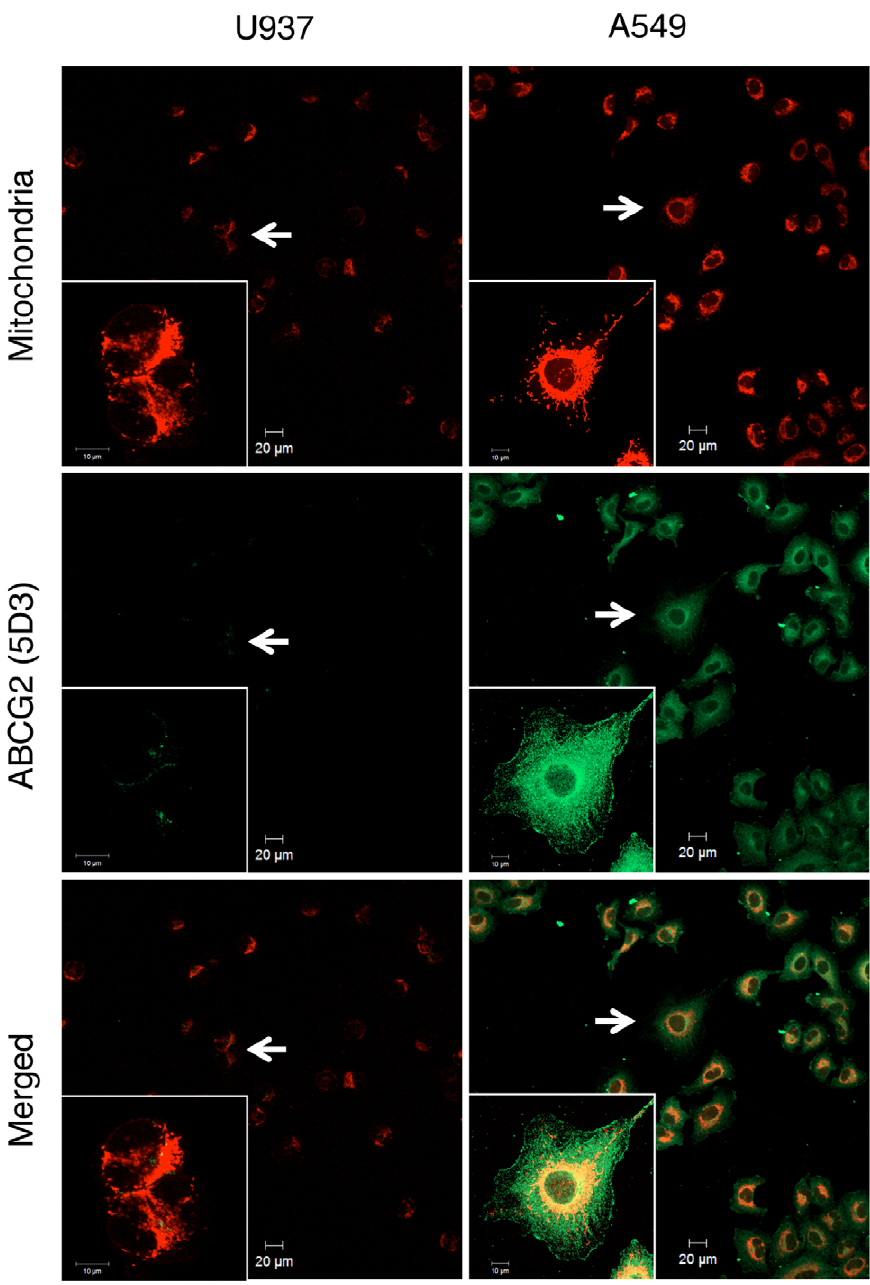
Figure 2. Confocal immunofluorescence microscopic analysis of ABCG2 localization. Live cells cultured on glass coverslips were incubated with 25 nM of Mito Tracker Red CMXRos to label mitochondria ( red ); then they were fixed and processed for ABCG2 protein immunostaining ( green ). Confocal images were obtained from cells immunostained with mouse monoclonal anti-ABCG2 antibody (5D3; R&D Systems) and Alexa Fluor 488- conjugated goat anti-mouse IgG antibody. Insets show a magnified area, indicated by white arrows.